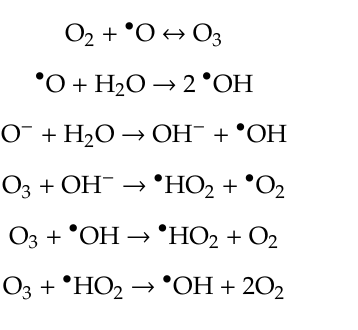
Table 1. The main characteristic conditions of the Dielectric Barrier Discharge (DBD) system.